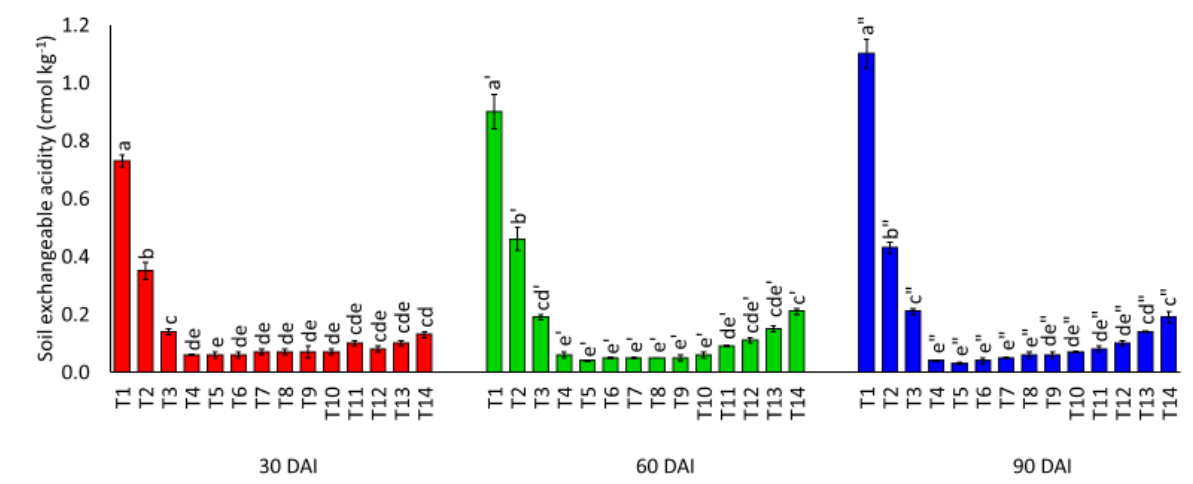
Figure 5. Effects of treatments on soil exchangeable acidity after thirty, sixty, and ninety days of incubation, where T1: soil alone, T2: Egypt rock phosphate alone, T3: Egypt rock phosphate + 100% charcoal, T4: Egypt rock phosphate + 100% sago bark ash, and T5: Egypt rock phosphate + 100% charcoal + 100% sago bark ash, T6: Egypt rock phosphate + 75% charcoal + 75% sago bark ash, T7: Egypt rock phosphate + 50% charcoal + 75% sago bark ash, T8: Egypt rock phosphate + 25% charcoal + 75% sago bark ash, T9: Egypt rock phosphate + 75% charcoal + 50% sago bark ash, T10: Egypt rock phosphate + 50% charcoal + 50% sago bark ash, T11: Egypt rock phosphate + 25% charcoal + 50% sago bark ash, T12: Egypt rock phosphate + 75% charcoal + 25% sago bark ash, T13: Egypt rock phosphate + 50% charcoal + 25% sago bark ash, and T14: Egypt rock phosphate + 25% charcoal + 25% sago bark ash.. Means with different letter(s) within the same incubation period indicate significant differences between treatments according to Tukey’s HSD test at p ≤ 0.05, i.e., a > b > c. Bars represent the mean values ± SE.